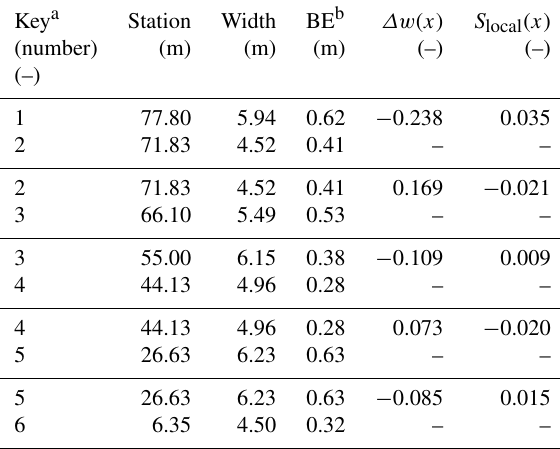
Table B2. Measurement details for Fig. 4 of Richards